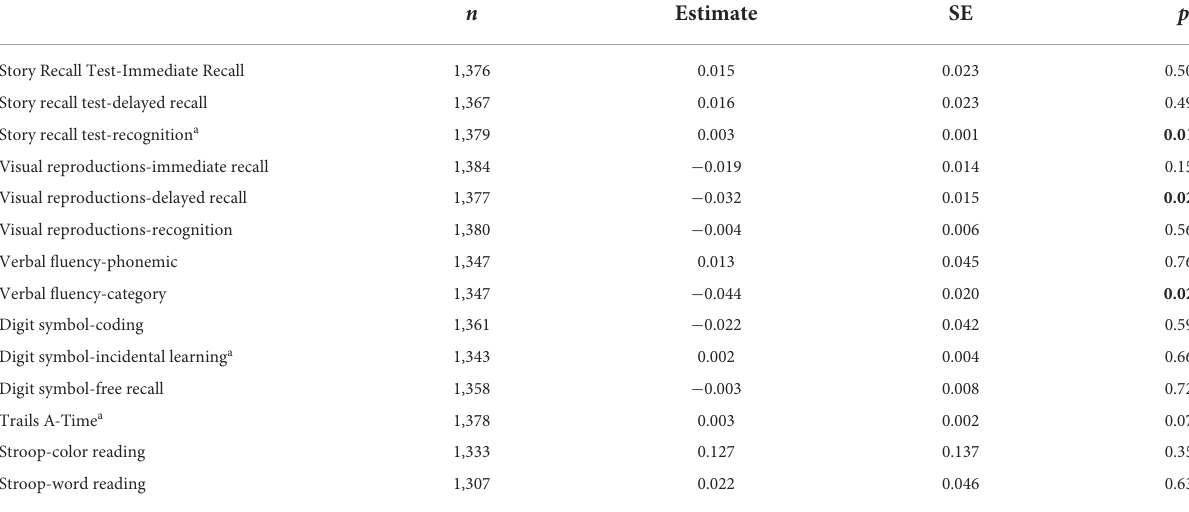
TABLE 4 Linear regression analyses between night systolic BPV and cognitive performance changes. n Estimate SE